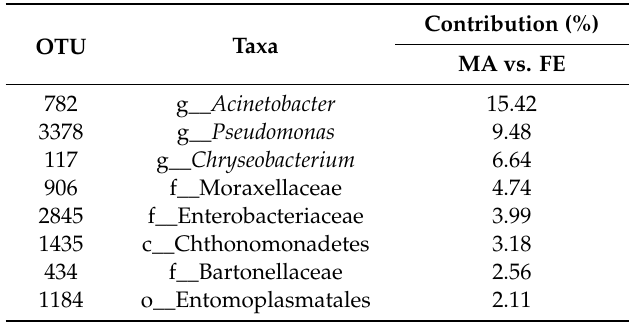
Figure 3. The intestinal bacterial community compositions across di ff erent treatments. LM: large male; MM: medium-sized male; SM: small male; FE: female. Table 1. SIMPER analysis showing the contribution of intestinal bacterial OTUs to the di ff erence between male and female beetles. Taxonomic leaves: o, order; c, class; f, family; g, genus. MA: Male beetle; FE: Female